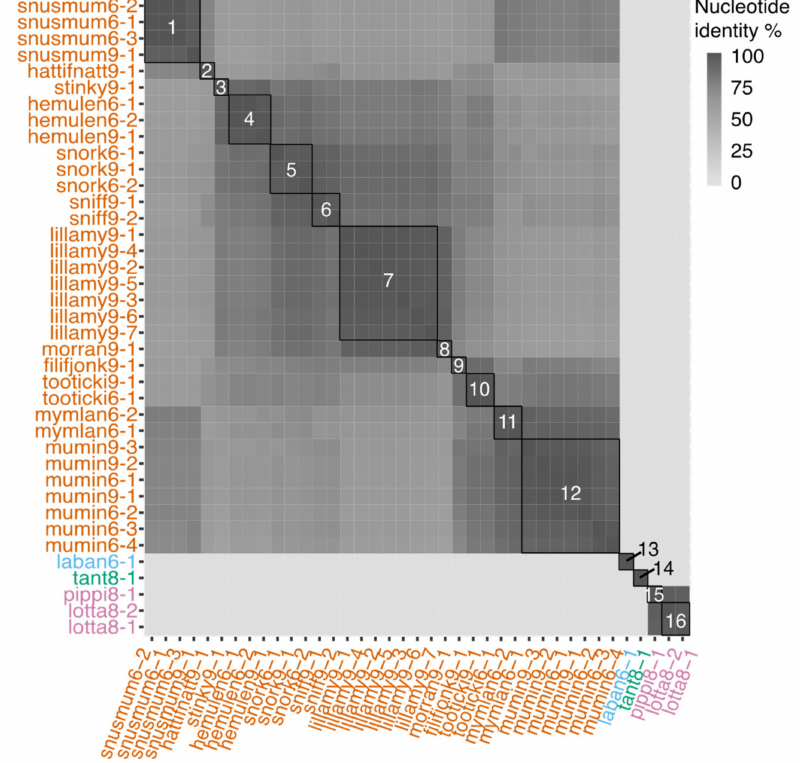
Figure 2. Similarity between the 38 lytic phages and the temperate phage based on Gegenees, which does a fragmented blastn between the entire genomes [67]; for details see Supplementary Table S3. Species are boxed with black while genera are coloured in the labels. Phages belonging to Muminvirus are orange, the isolate that constitutes Labanvirus is blue, Tantvirus is green and the isolates that belong to Pippivirus are pink. The species are named with the Flavobacterium virus and then 1 = Snusmum, 2 = Hattifnatt, 3 = Stinky, 4 = Hemulen, 5 = Snork, 6 = Sni ff , 7 = Lillamy, 8 = Morran, 9 = Filifjonk, 10 = Tooticki, 11 = Mymlan, 12 = Mumin, 13 = Laban, 14 = Tant, 15 = Pippi, 16 =